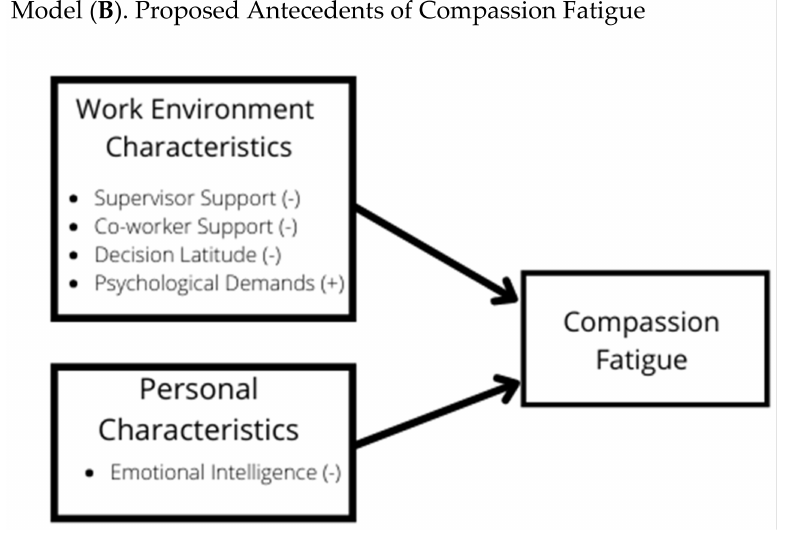
Figure 1. Hypothesized Models.